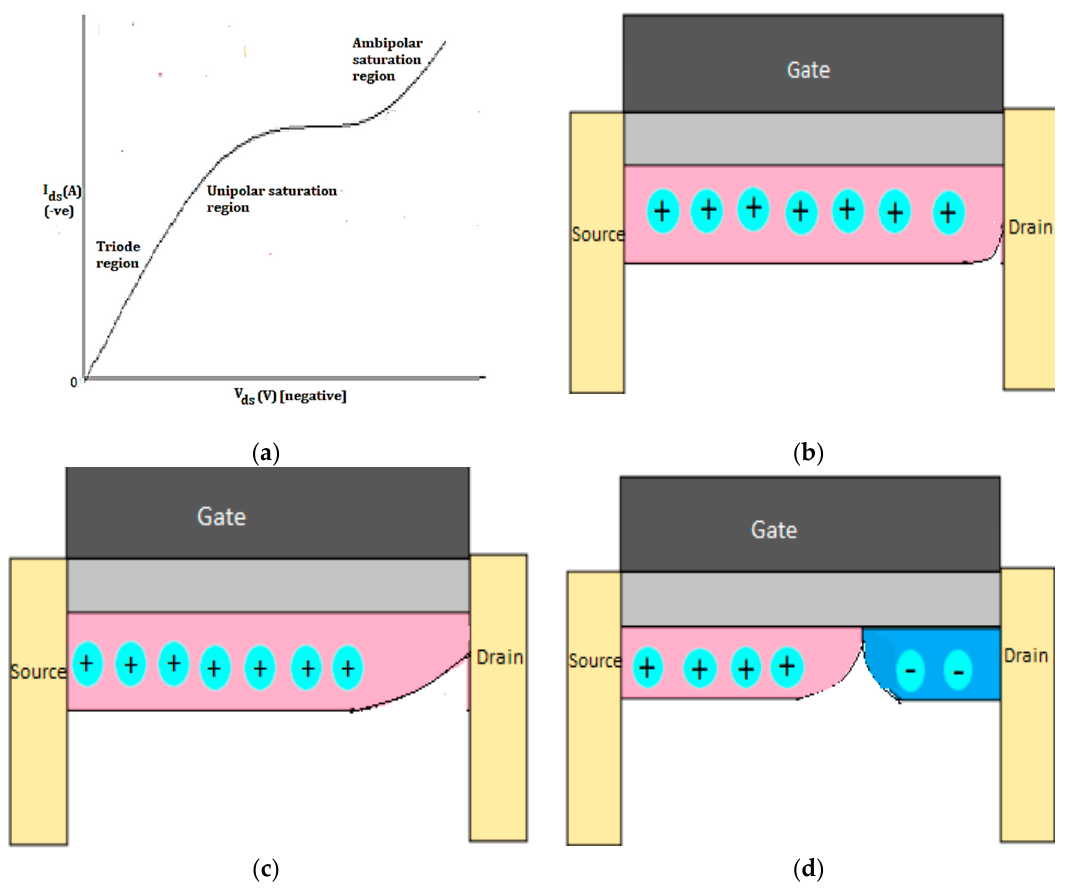
Figure 3. Diagrammatic representation of the charge flow in graphene field effect transistor. ( a ) I-V curve of transistor. ( b ) Triode region: Flow of holes and a minimum charge density point started to form at the drain end. ( c ) Unipolar saturation region: There is a pinching at the drain terminal. ( d ) Ambipolar region: Graphene channel illustrating both holes’ and electrons’ transport.